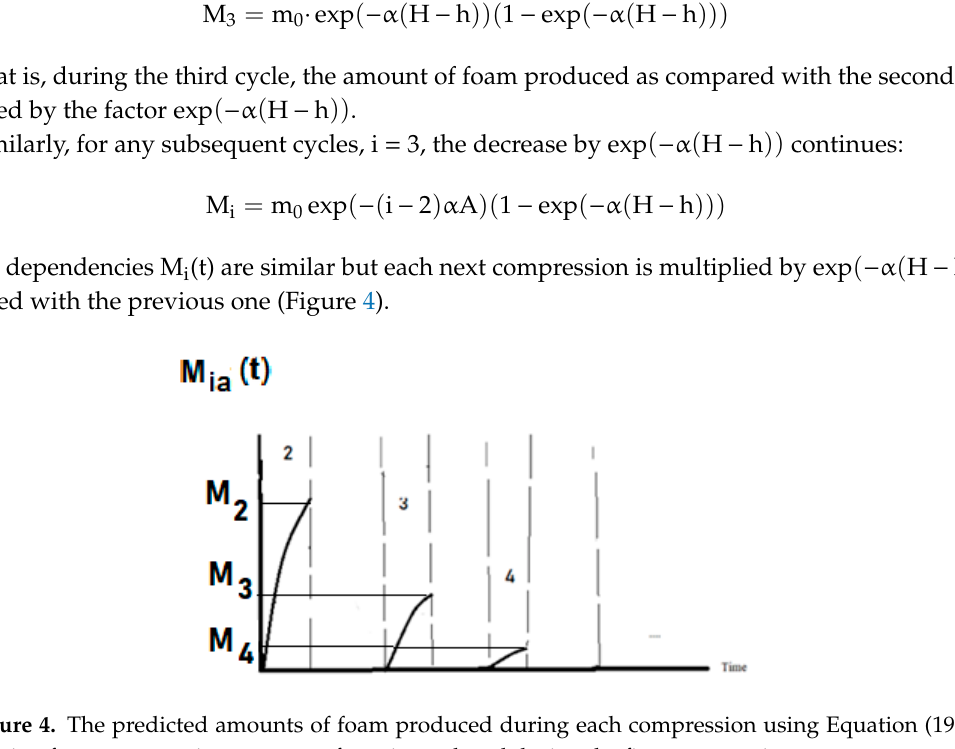
Figure 4. The predicted amounts of foam produced during each compression using Equation (19), starting from compression two as no foam is produced during the first compression.